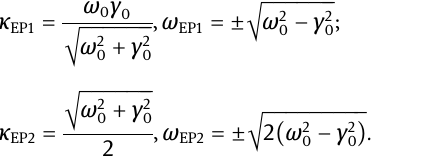
= 0 . 05, we fi nd two second-order EP when κ = ω 0 γ 0 ̅̅̅̅ 0